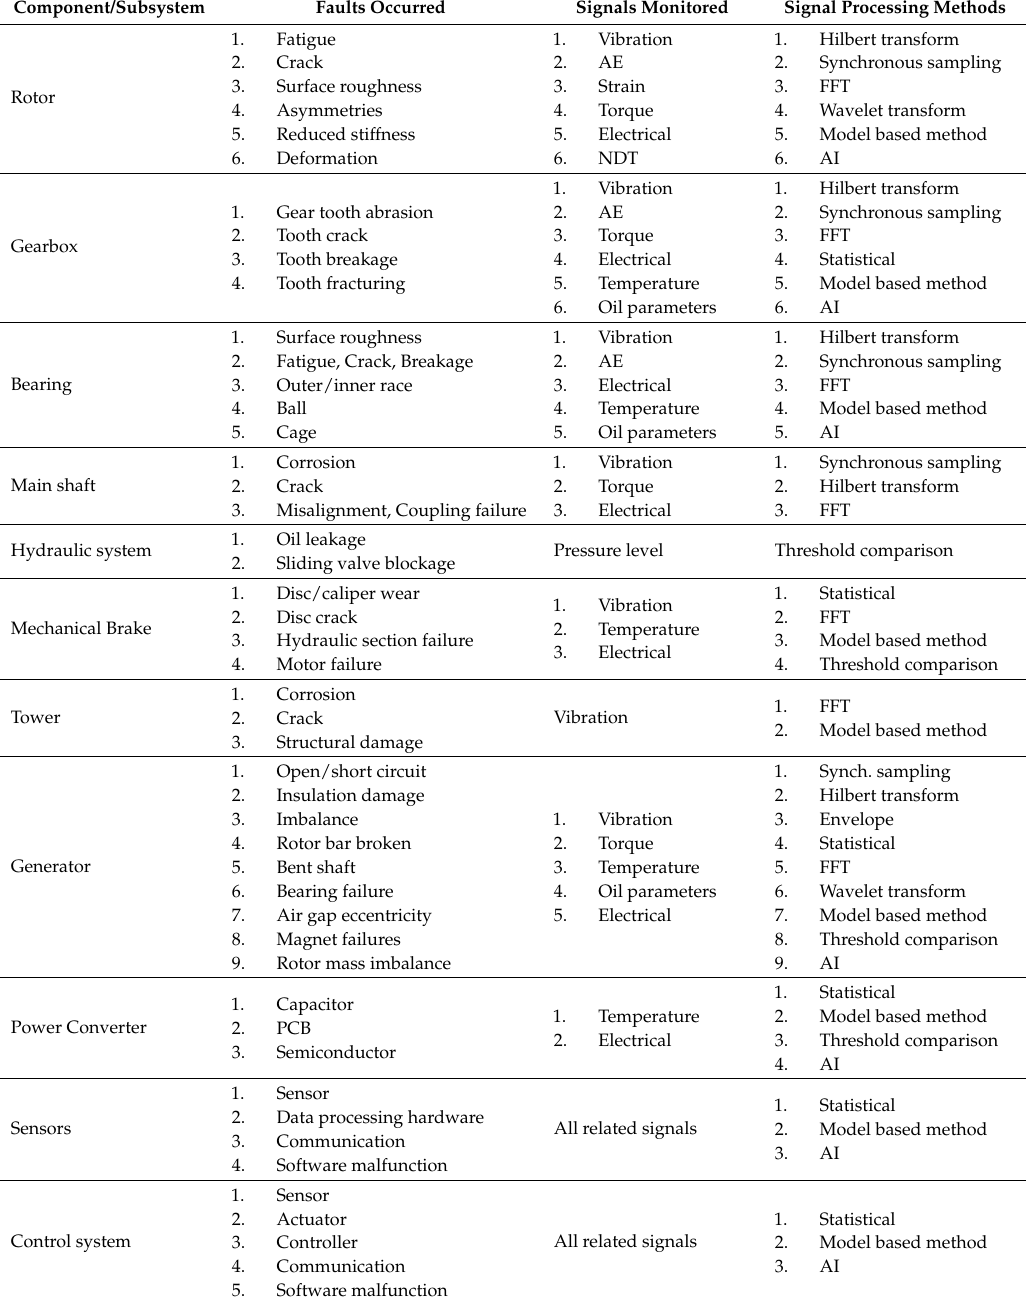
Table 1. Summary of Faults, Signals and Signal processing